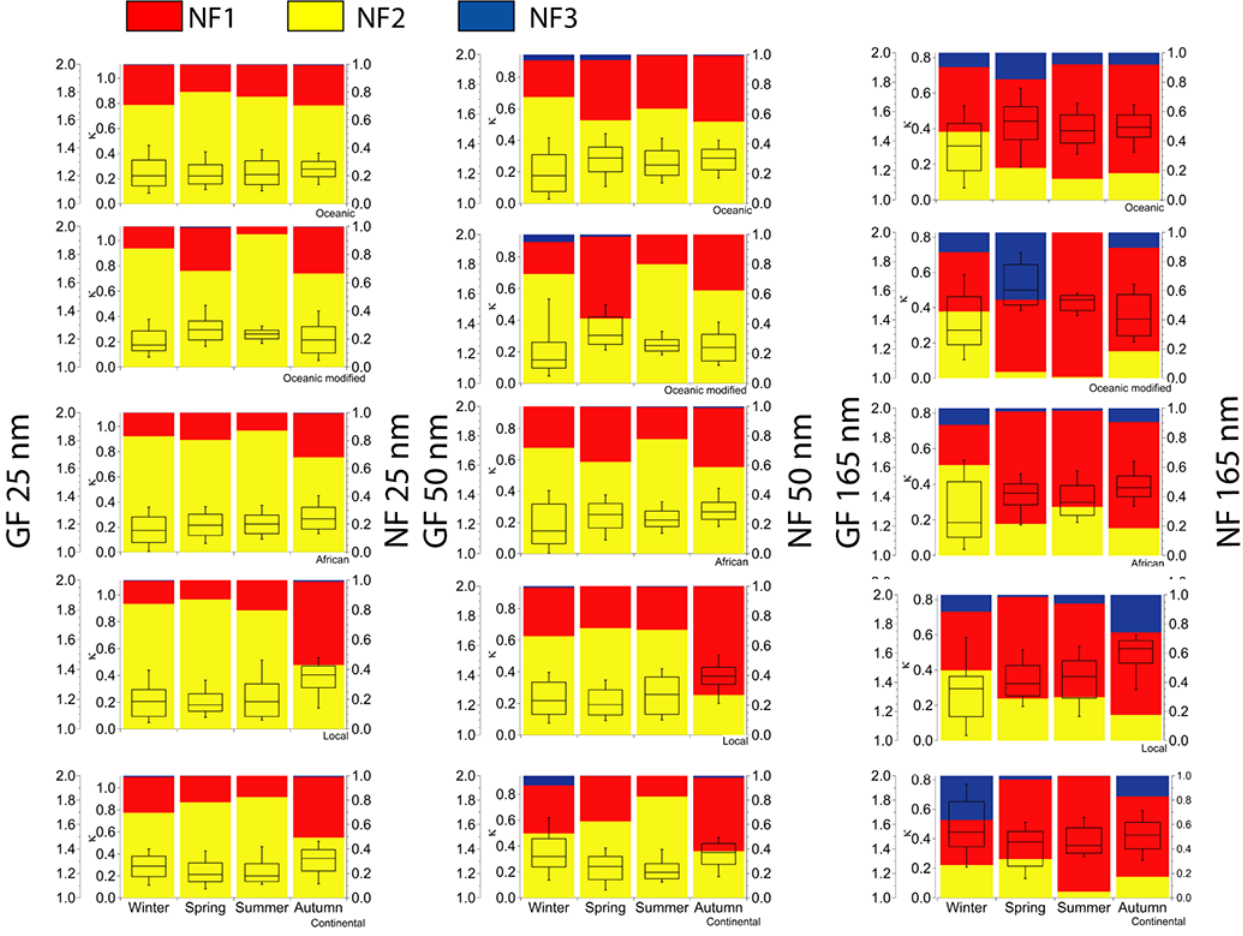
Figure 11. Variations in hygroscopic growth factor (GF), kappa value ( κ) and number fractions (NF) measured at RH90 as a function of air mass origin and season for particles in the nucleation mode (left panels), Aitken mode (middle panels) and accumulation mode (right panels). The figures show the median GF value, with the bottom and top sides of the box giving the 25th and 75th percentiles, and the extremities the 10th and 90th percentiles. The coloured bars illustrate the NF of particles found in each hygroscopic mode.